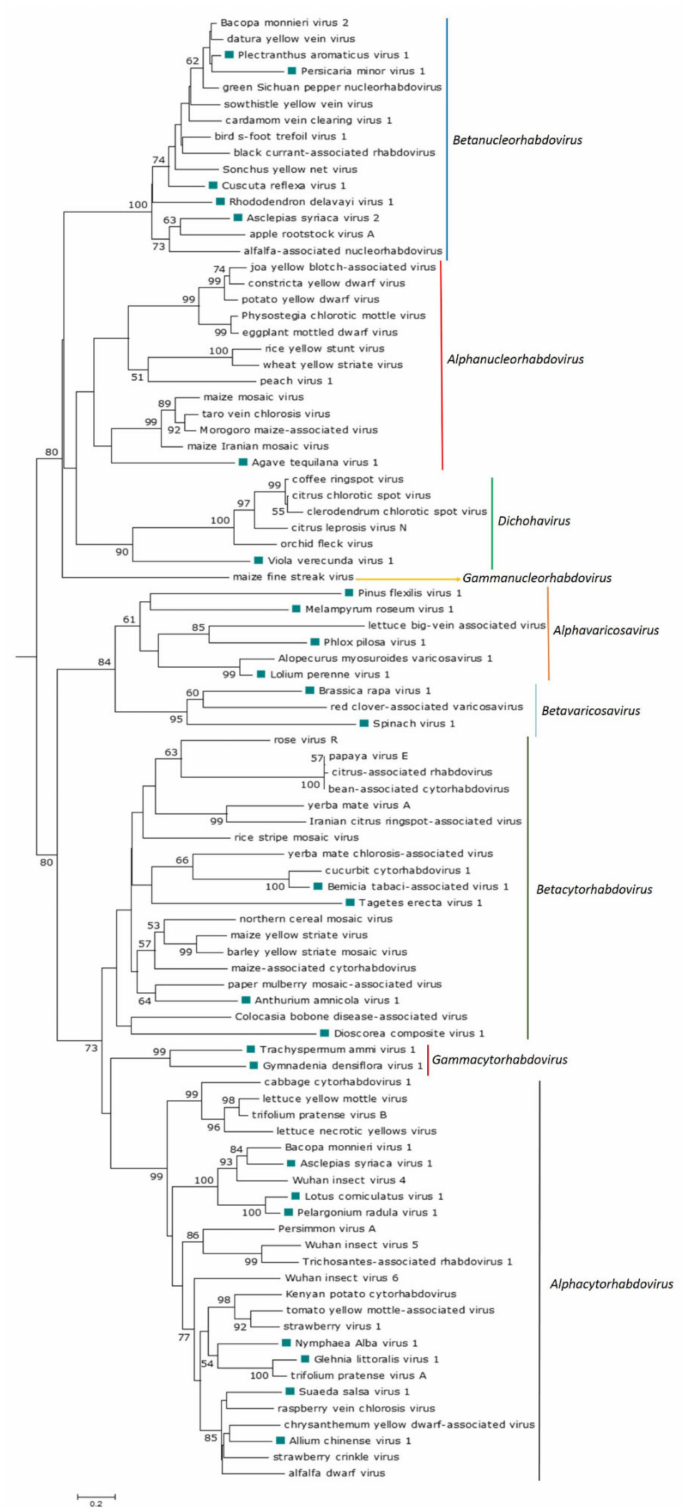
Figure 2. Maximum Likelihood phylogenetic tree based on a multiple amino acid alignment of the N protein sequences of plant rhabdoviruses constructed with the WAG + G + F model. Bootstrap values following 1000 replicates are given at the nodes, but only the values above 40% are shown. The scale bar indicates the number of substitutions per site. The viruses identified in this study are noted with green rectangles. The accession numbers of every virus used to construct the ML tree are listed in Supplementary Table